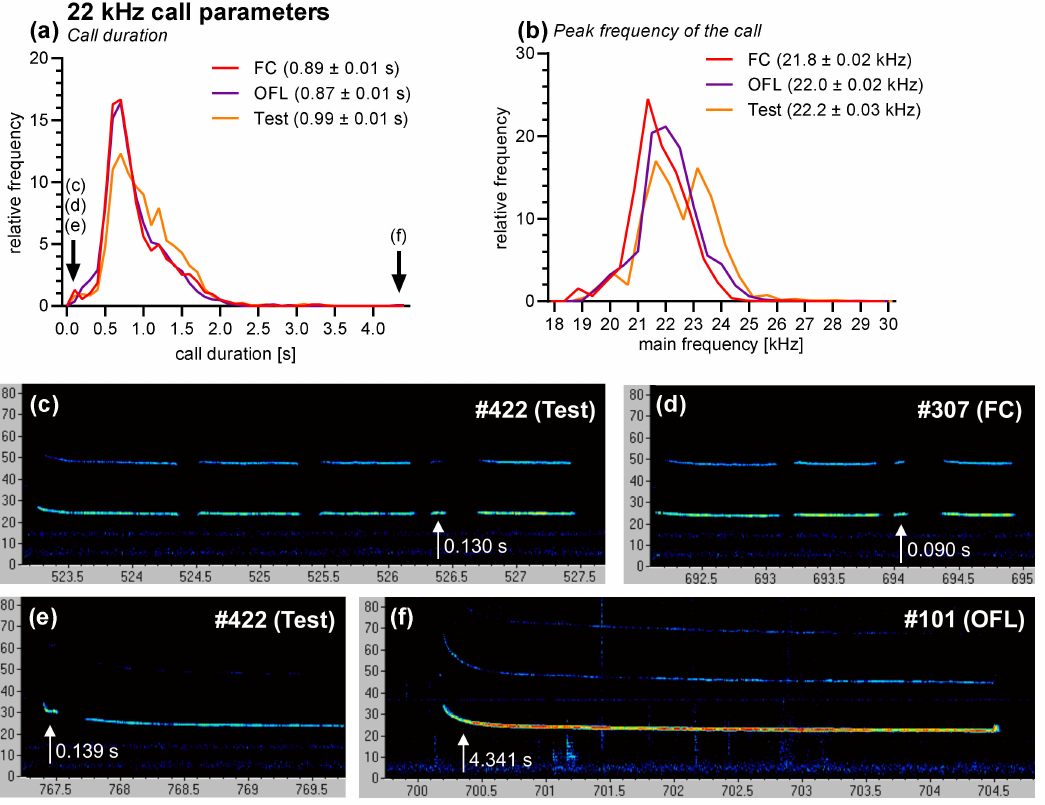
Figure 4. Parameters of the 22 kHz calls. Histogram depicting ( a ) the distribution of the call duration and ( b ) peak frequen- cies of the calls in the different phases (mean ± SEM). ( c – f ) Examples of calls with very short ( c – e ) or exceptionally long ( f ) call duration. Abbreviations: FC, fear-conditioning session; OFL, observational fear learning session; Test, retention